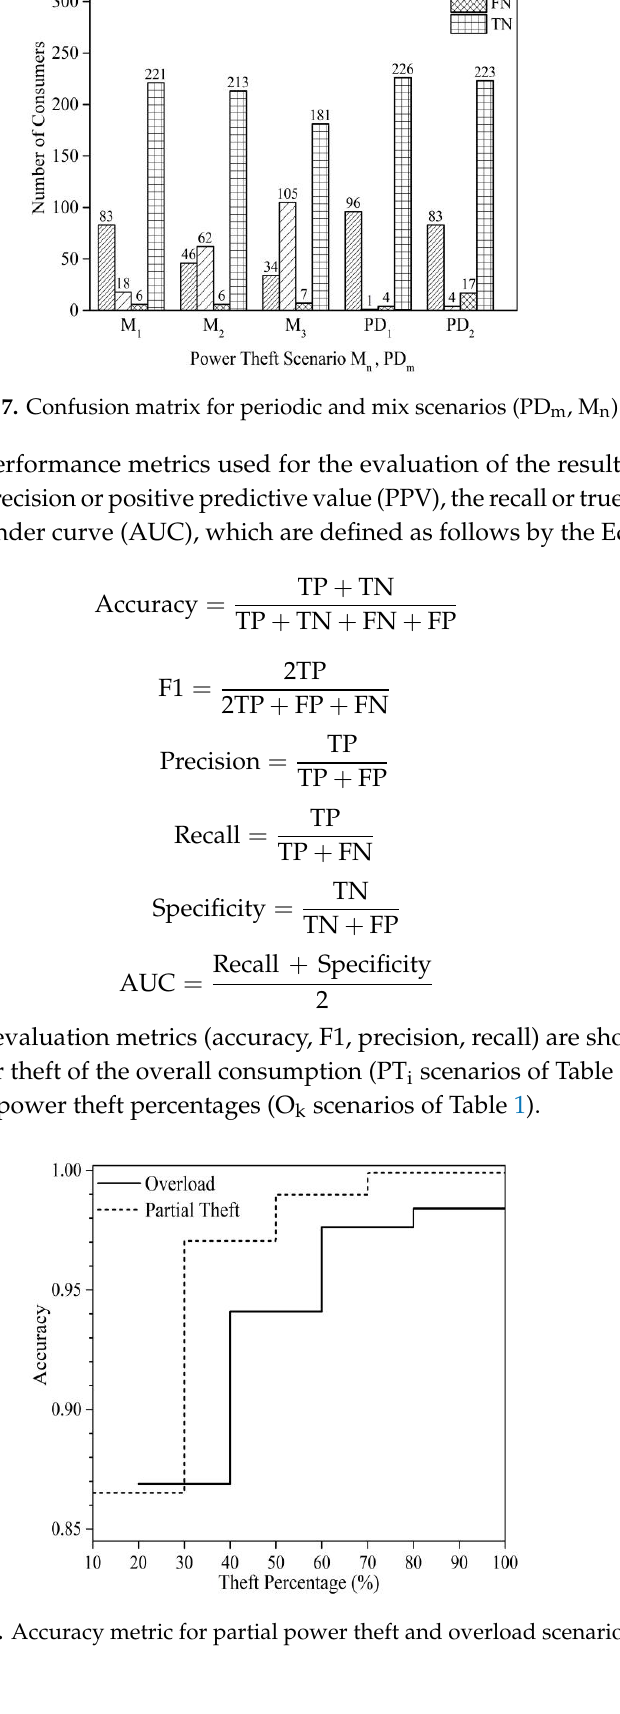
Figure 9. F1 metric for partial power theft and overload scenarios.